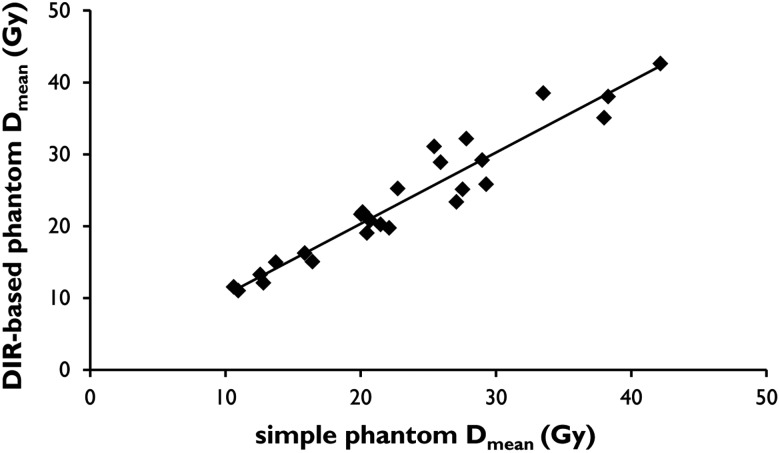
Scatter diagram comparing DIR-based phantom Dmean with simple phantom Dmean. A strong correlation between the DIR-based phantom Dmean and the simple phantom Dmean was observed (correlation coefficient = 0.96). Abbreviations: DIR = deformable image registration.